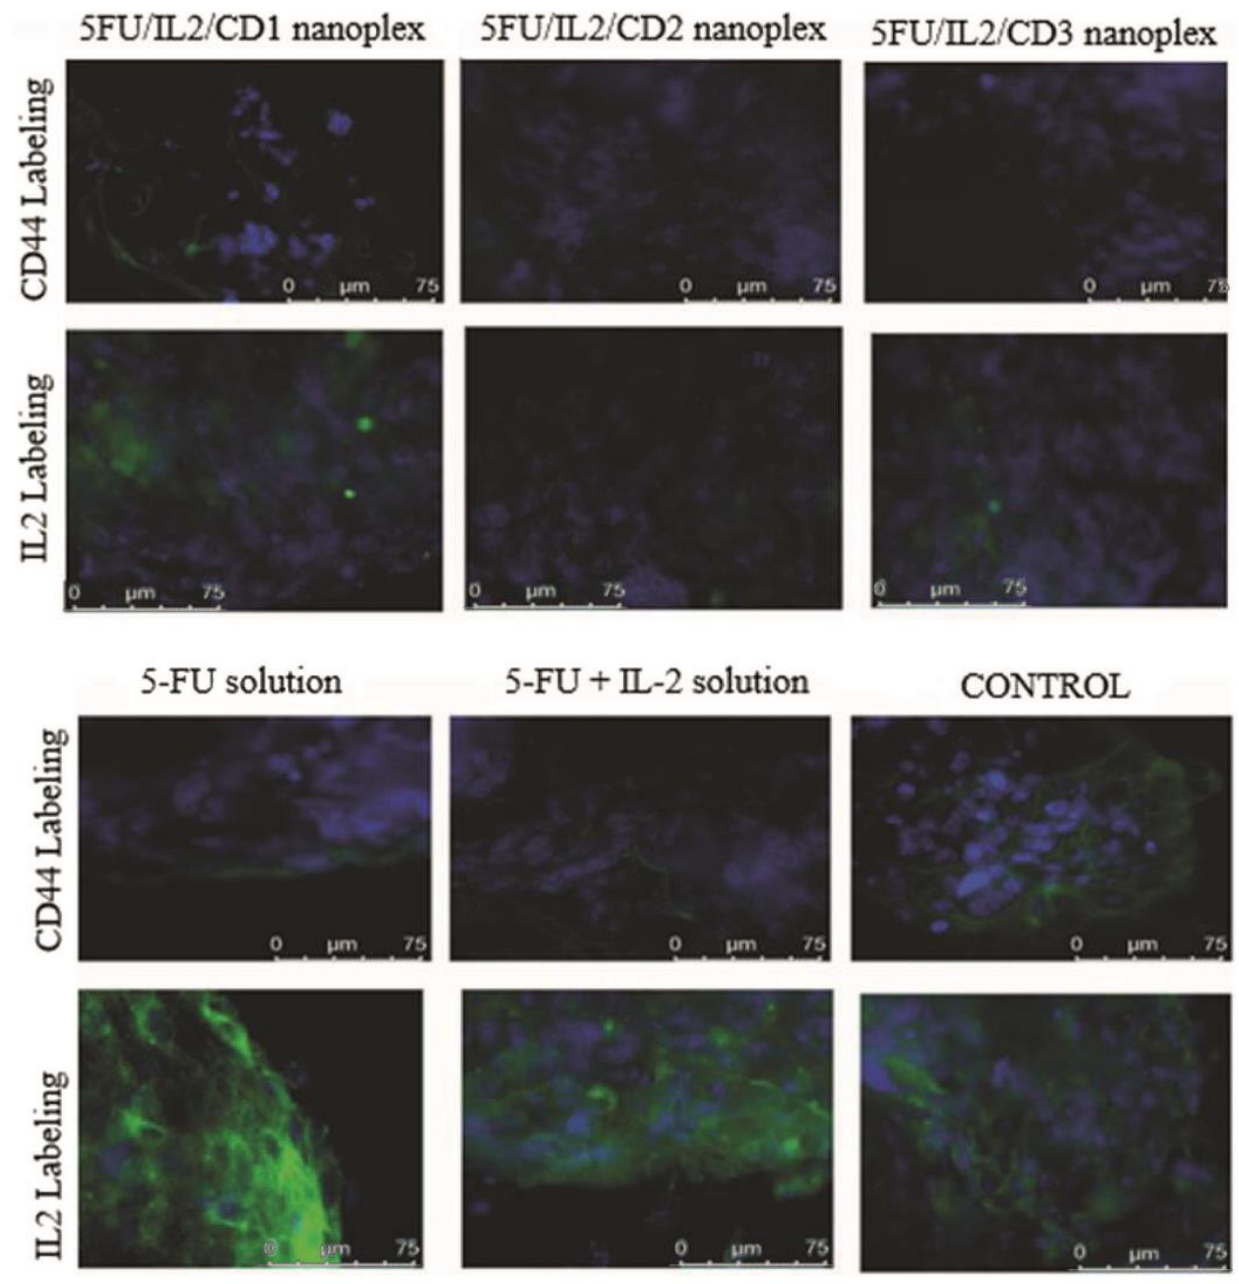
Figure 6. The representative micrographs of colon cancer spheroids labeled with CD44 and IL-2. Nucleus: (DAPI) ×1000.